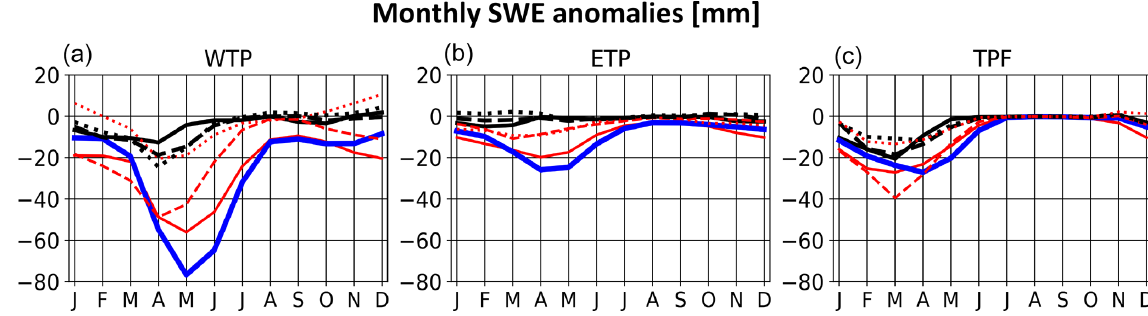
Figure 7. Monthly time series of snow water equivalent (SWE) changes (millimeters) due to BCD effects across (a) the WTP, (b) ETP, and (c) TPF.